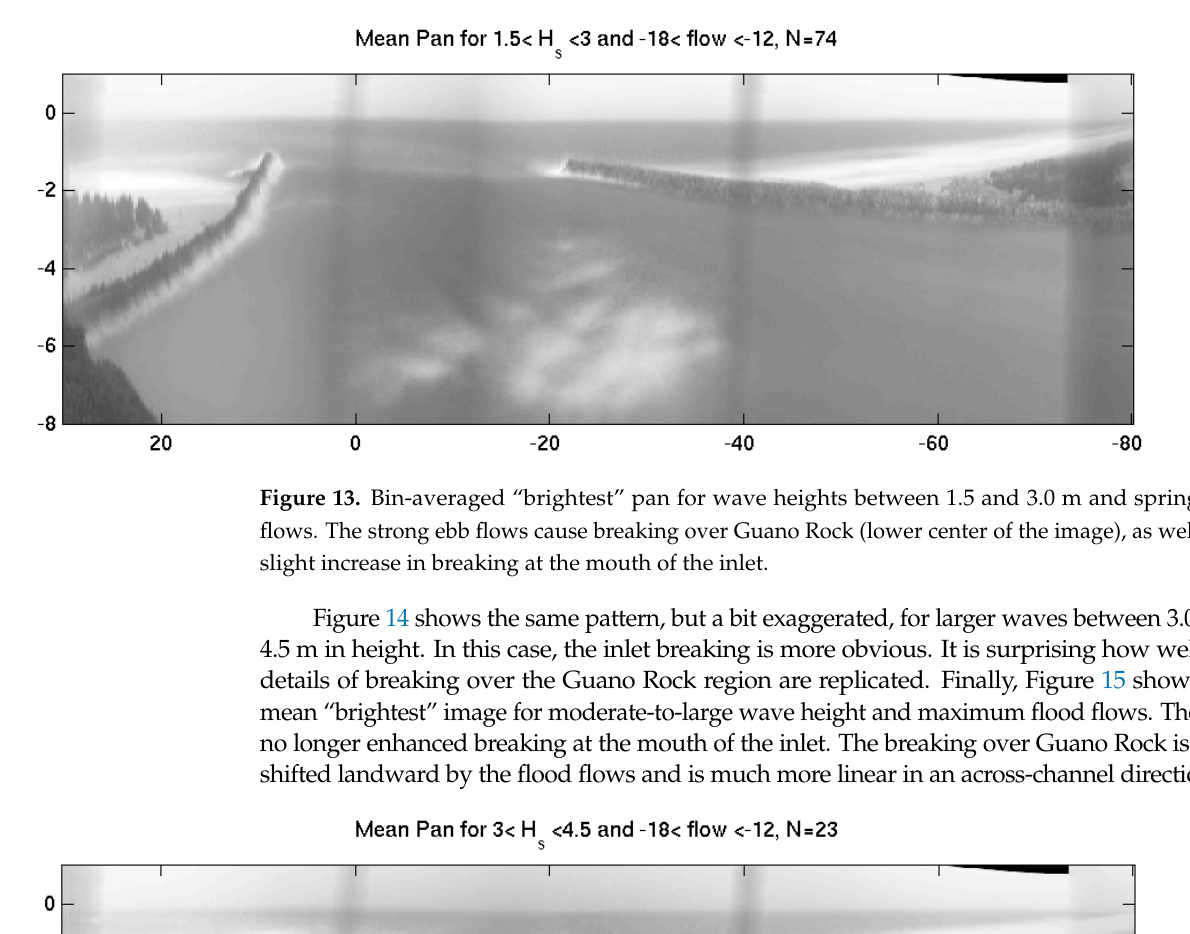
Figure 15. Bin-averaged “brightest” pan for wave heights between 3.0 and 4.5 m and spring flood flows. There is no longer any enhanced breaking in the inlet mouth and the breaking over Guano Rock is shifted landward by the flood flow in a more cross-channel linear direction. Both wave height and tidal flow seem to play a role in these breaking patterns. To explore this more systematically, the 24 bin-averaged pan images (six flow bins by four wave height bins) were computed and the mean intensities were measured in three re- gions, Guano Rock, the mouth of the inlet between the jetties (called Offshore), and a mid- channel region away from Guano Rock that could act as an intensity normalization (Fig- ure 16).